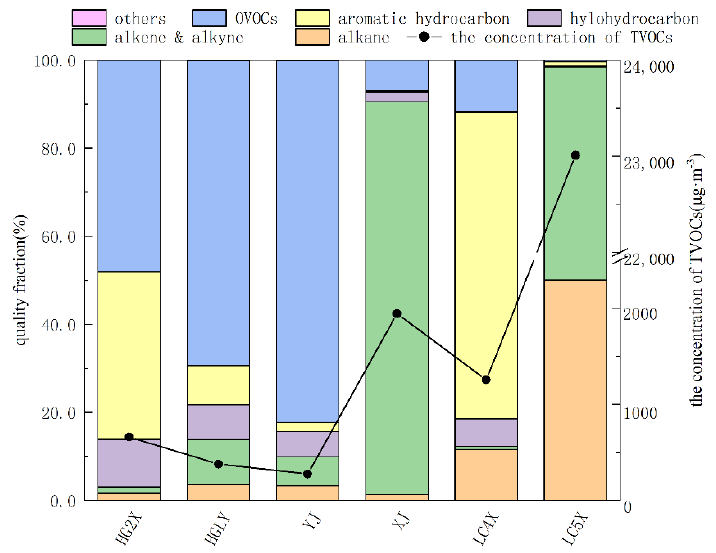
Figure 1. VOCs components of six circulating cooling water systems.